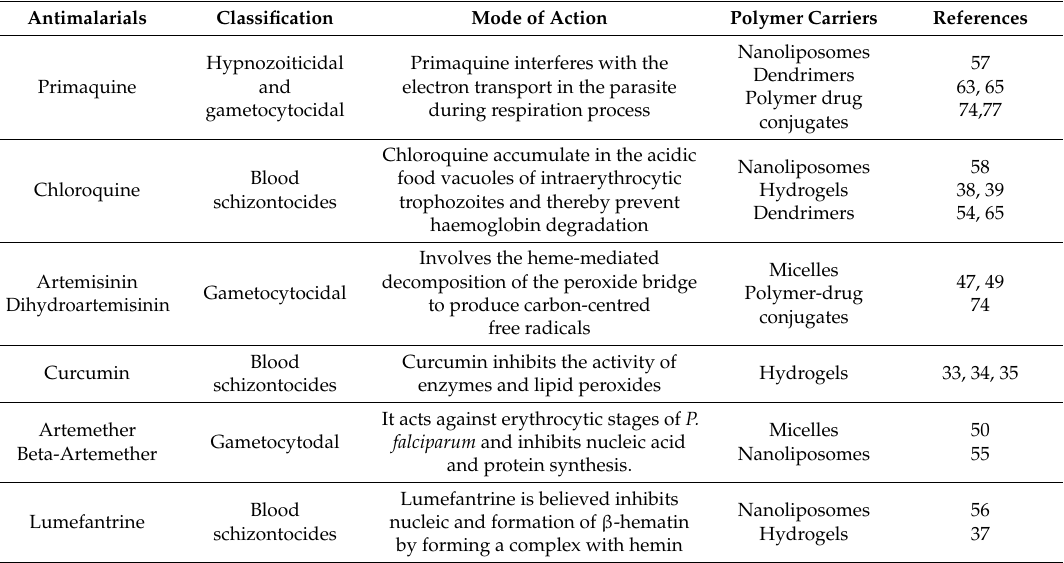
Table 1. Classification of antimalarials and their mode of